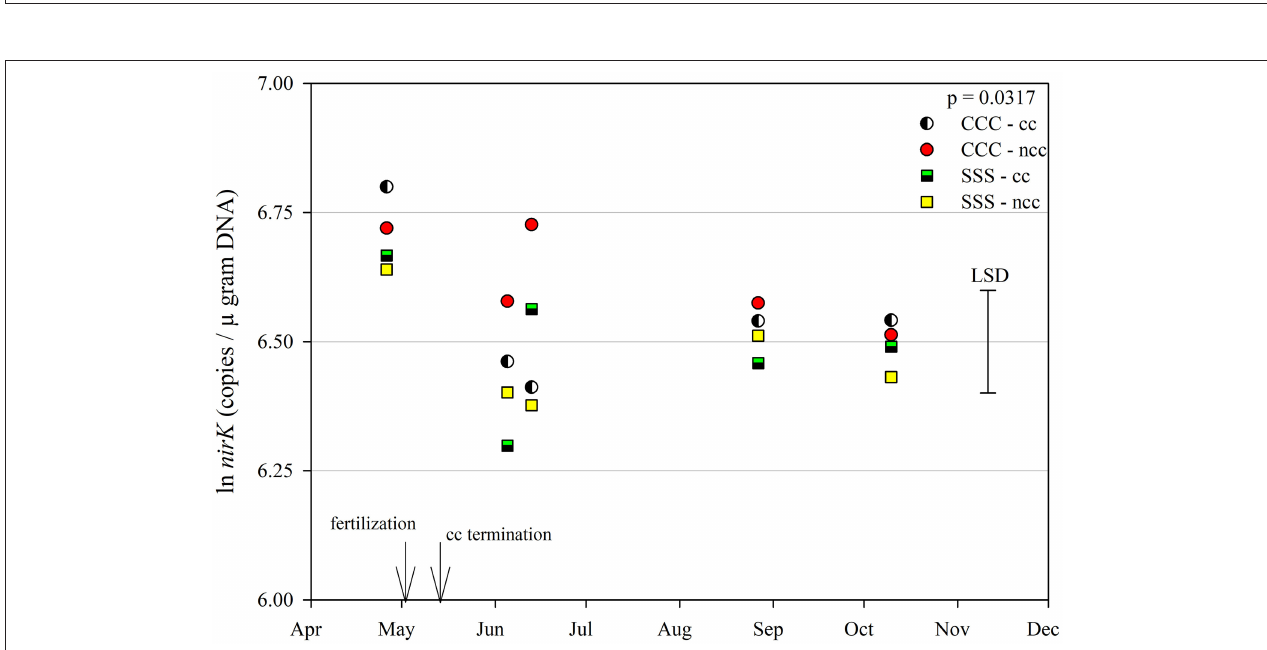
FIGURE 7 | Mean lognormal transformed soil nirK (copies µ gram DNA − 1 ) throughout the 2019 growing season separated by crop rotation [CCC, continuous corn (circles); SSS, continuous soybean (squares)] and cover crop [CC, cover crop (partial fill); NCC, no cover crop (solid fill)]. Significant differences in treatment means can be interpreted by the Least Square Differences (LSD) error bar to the right of the figure. Mean values that fall beyond the distance of the LSD are significant at α = 0.10.